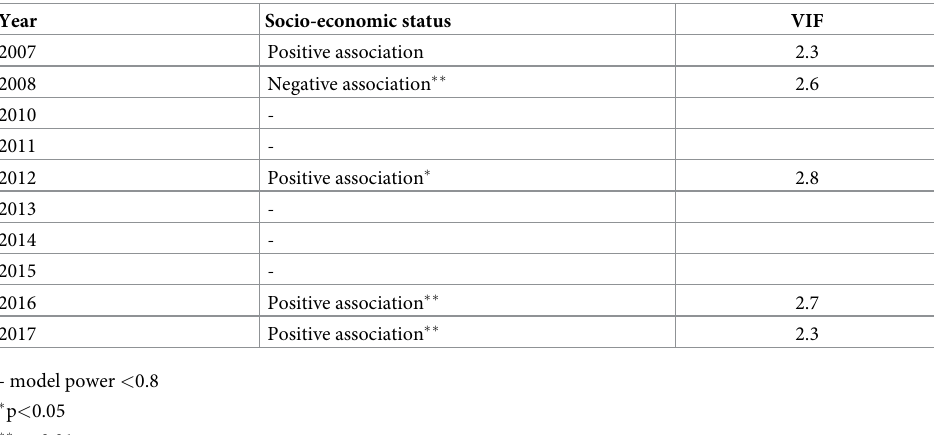
Table 2. Yearly association between West Nile Virus (WNV) incidence and socio-economic status at county level in Alabama. The association was estimated using regression model adjusted by land use, rainfall, flooding events, and population density. No WNV cases were reported during the year 2009 in